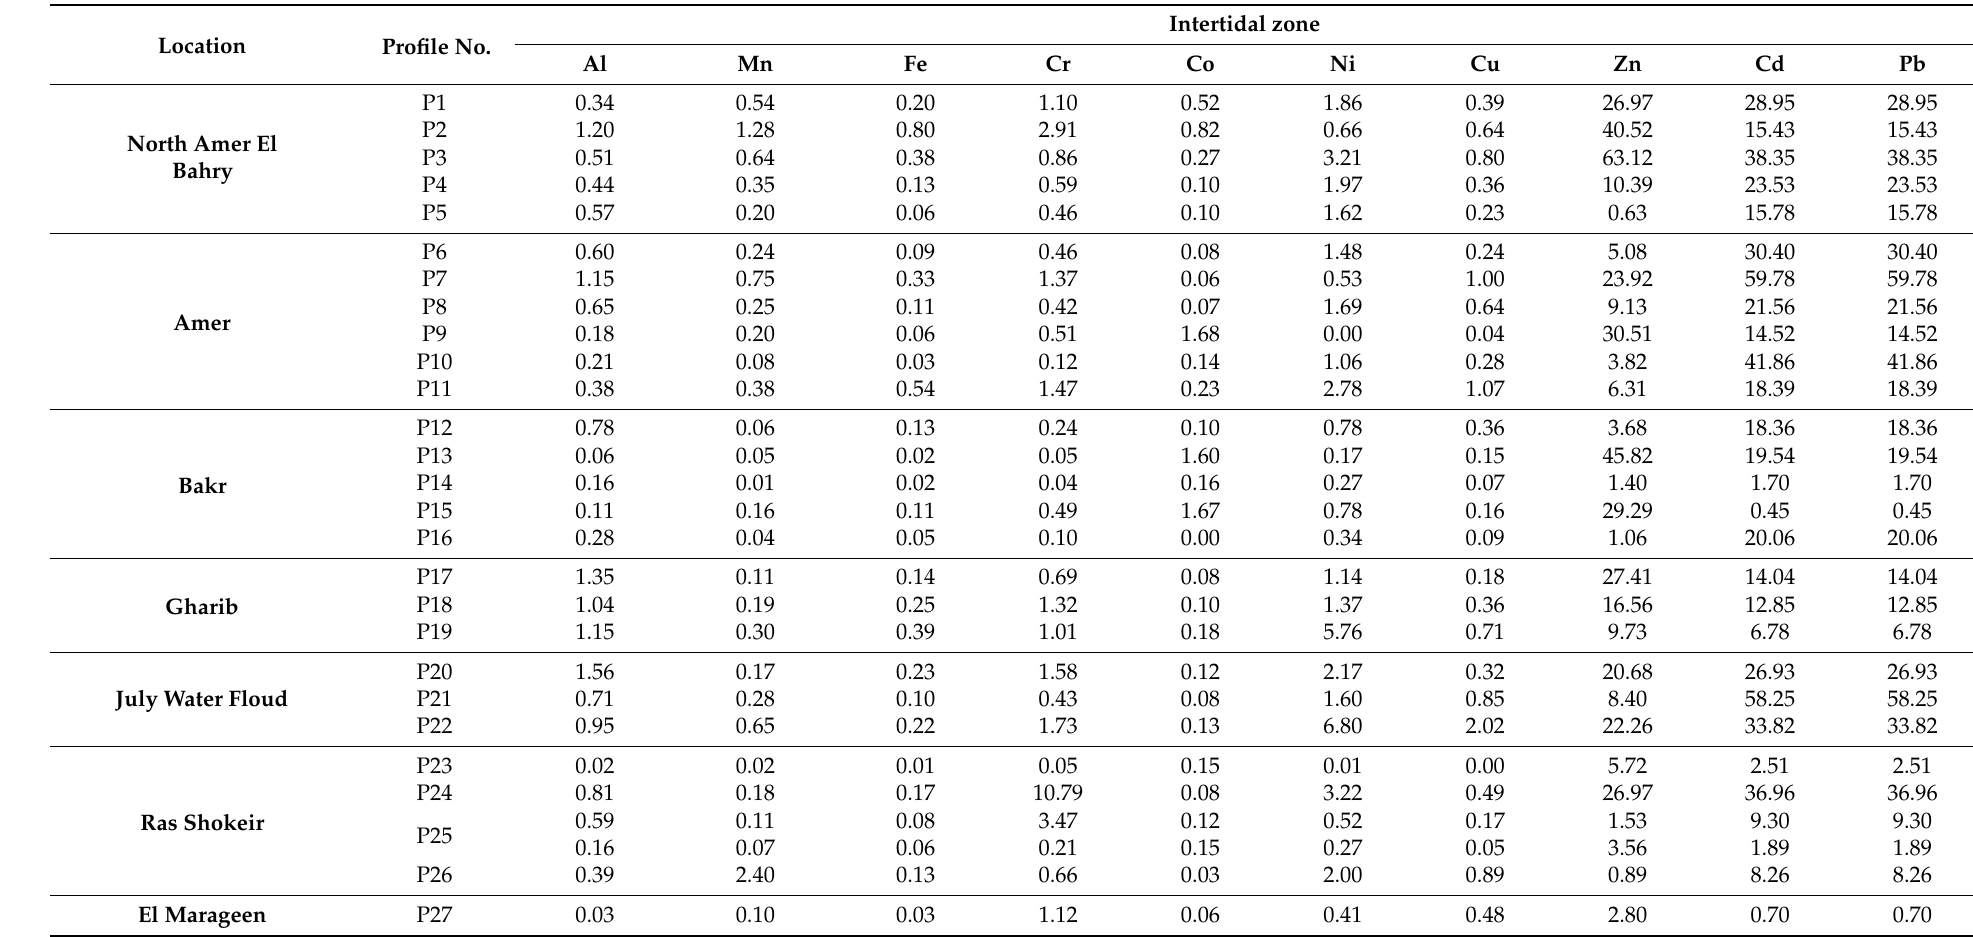
Table 5. Contamination factor (CF) results of metals in sediment